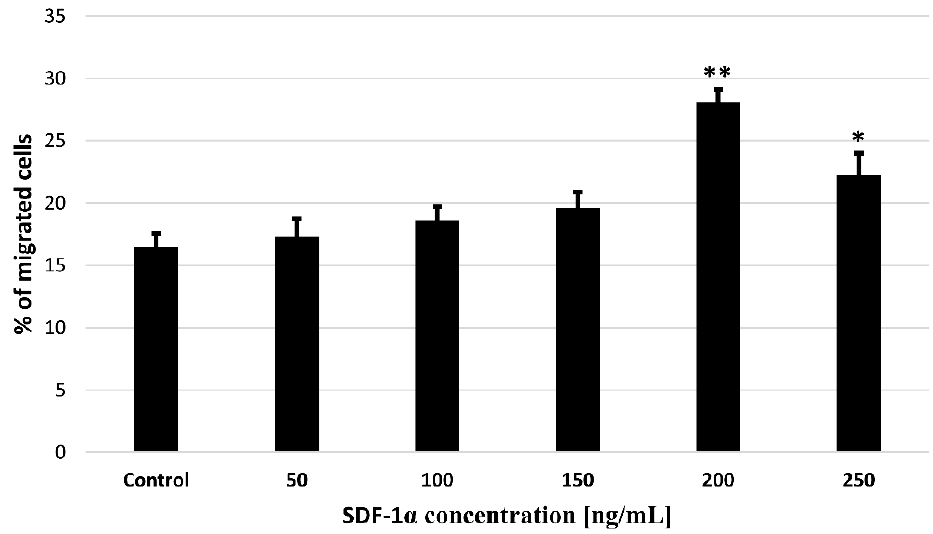
Figure 5. Effects of SDF-1 α on bmMSCs migration in vitro. Quantification of migration of bmMSCs induced by different concentration of SDF-1 α (10, 50, 100, 150, 200 and 250 ng/mL) for 24 h was detected with Transwell migration assay. Values are means ± SD ( n = 10). p -values of statistical significance are represented as follows: * p < 0.05; ** p < 0.01.